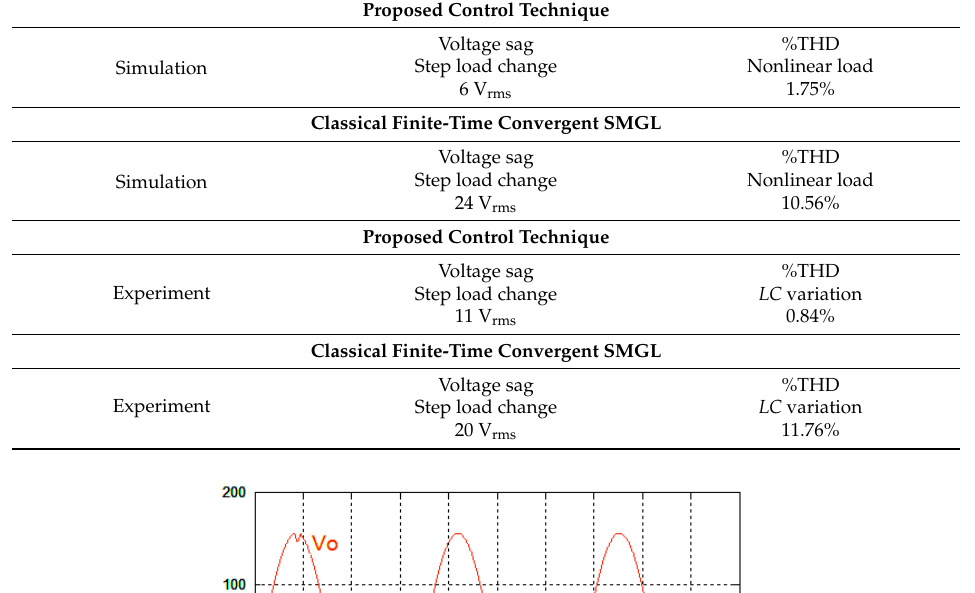
Table 2. Voltage sag and percent total harmonic distortion (%THD).